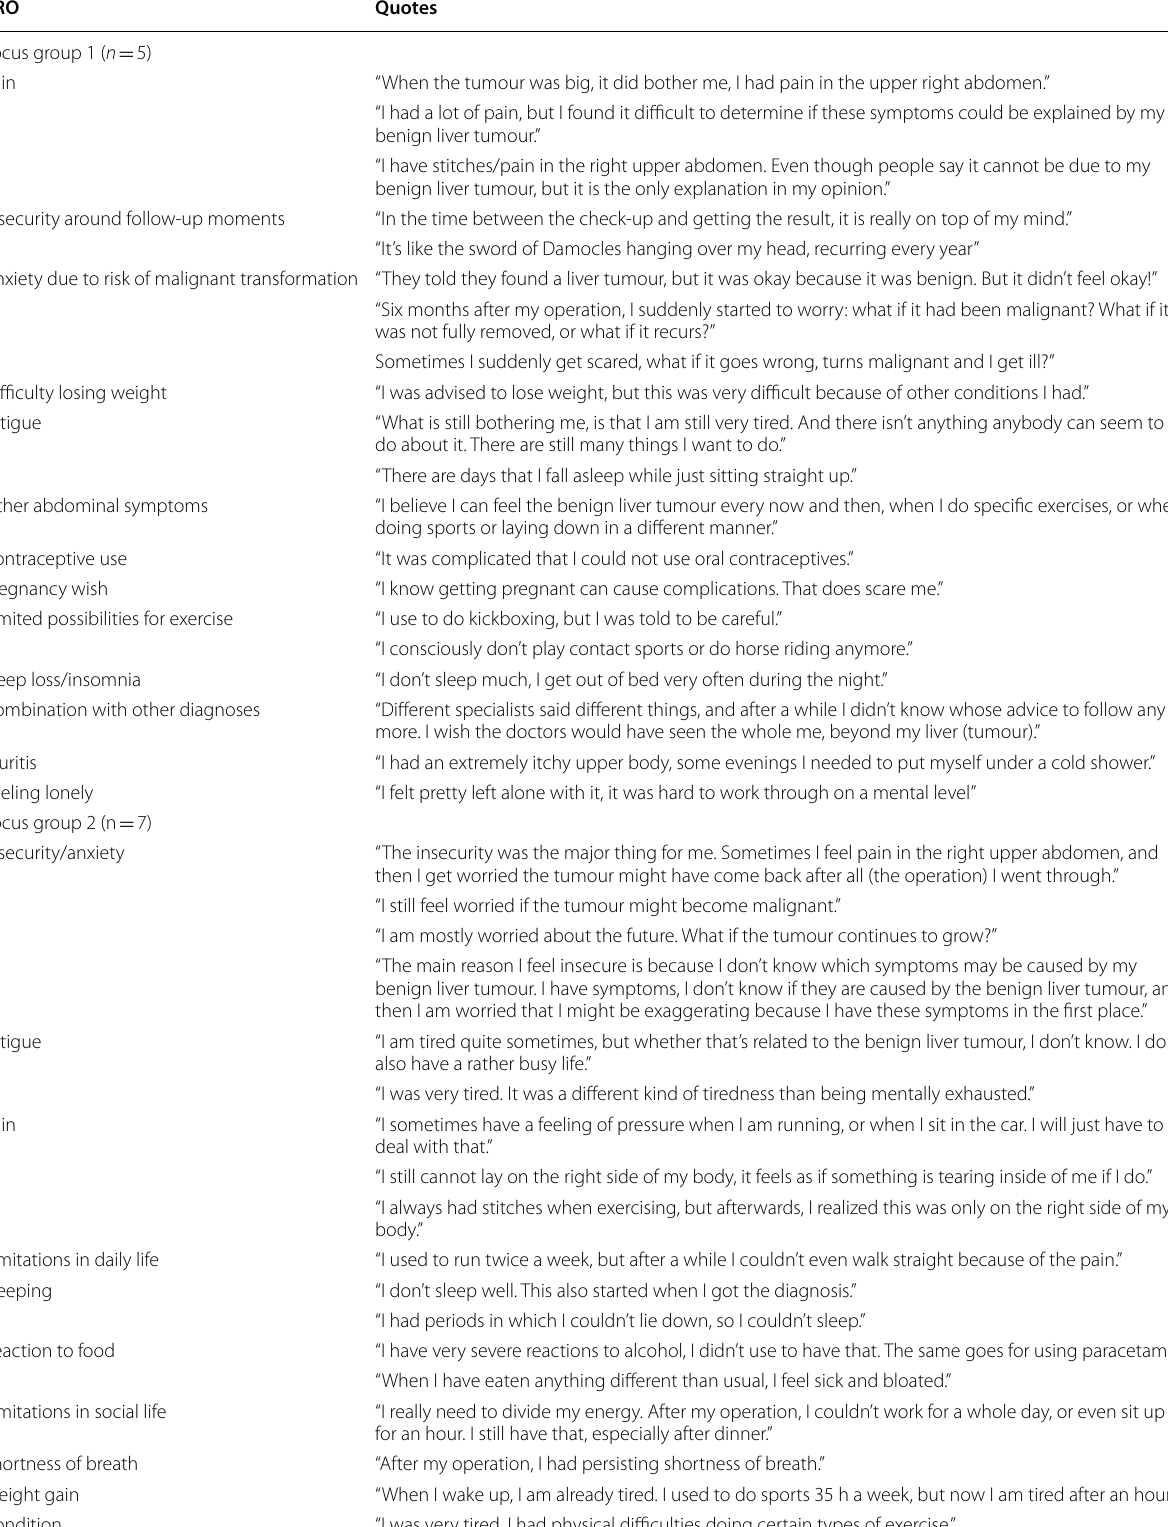
Table 1 PROs identified during focus groups for patients with BLTC PRO Quotes Focus group 1 ( n =